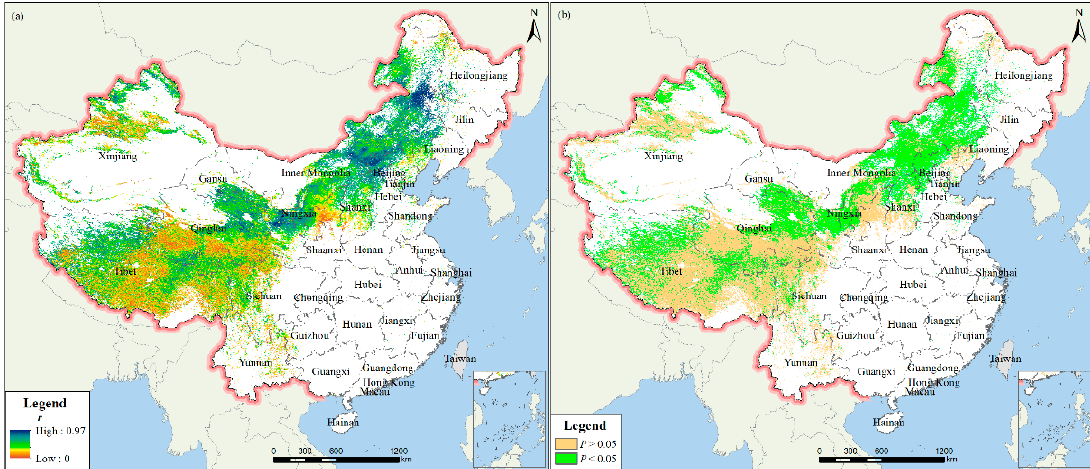
Figure 12. Spatial distribution of ( a ) multiple correlation coefficient between ANPP and the average temperature and total precipitation in the growing season and ( b ) the significance level.